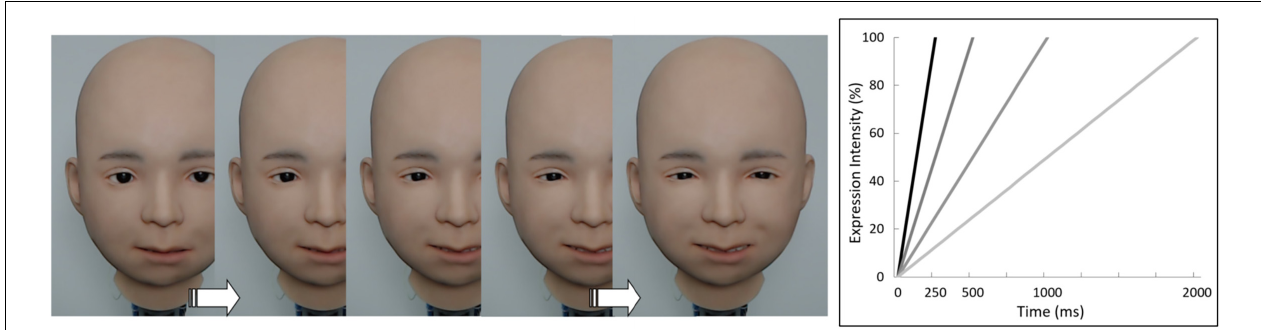
FIGURE 4 | Illustration of the dynamic facial expression stimuli used in Study 3. (Left) Nikola’s face changed from a neutral expression to one of six emotional expressions. (Right) Schematic illustration of the four speed